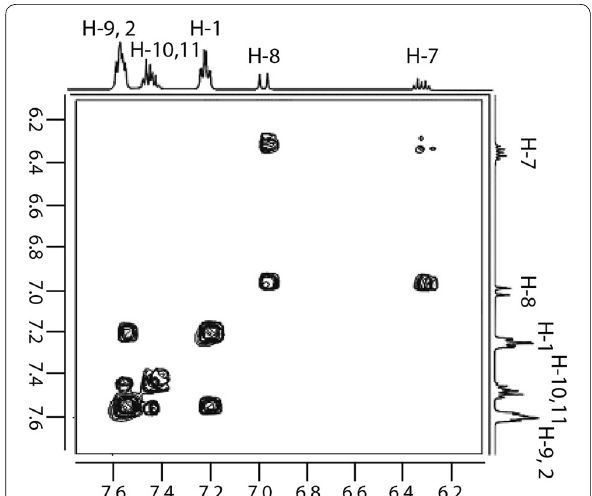
Fig. 6 Part of the 2D 1 H- 1 H COSY spectrum (500 MHz) of a mixture of β-CD and FLN, displaying through the bond interaction of aromatic protons of FLN